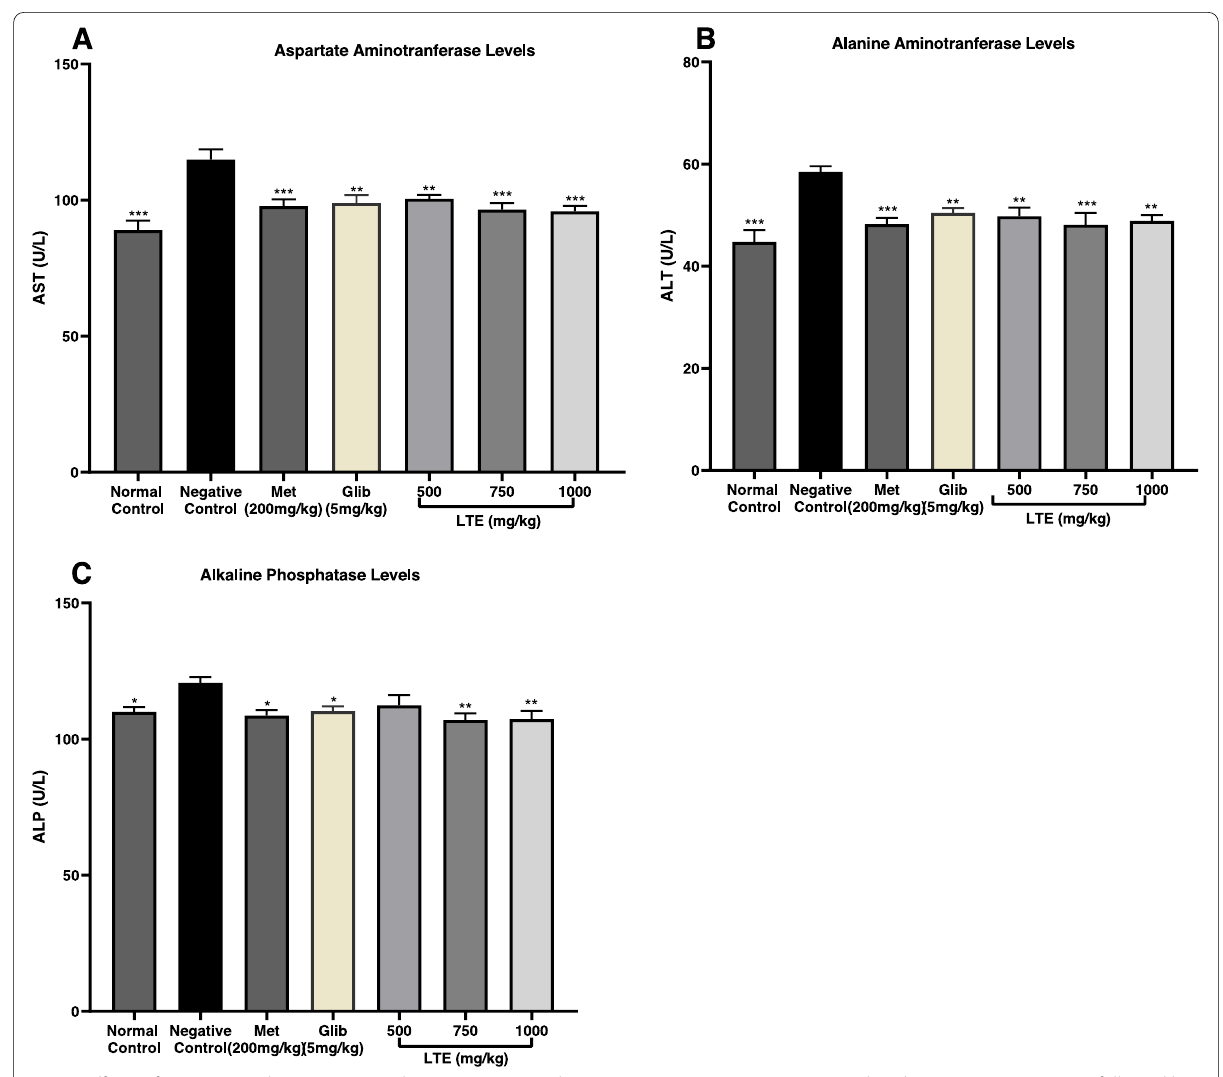
Fig. 5 Effects of LTE on some liver enzymes. Values were expressed as mean Dunnett’s multiple comparisons test. * represents statistical significance at p < 0.05 vs. the negative control